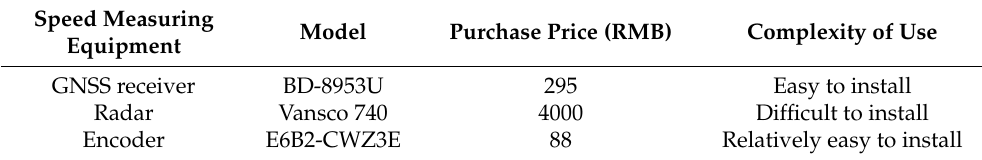
Table 8. Information about three kinds of speed measuring equipment. Speed